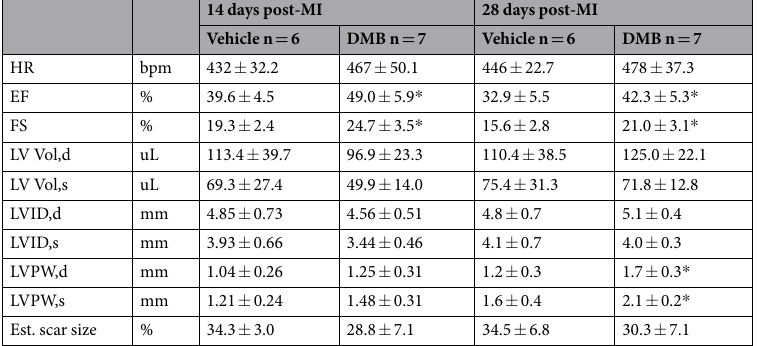
Table 1. DMB administered after permanent coronary artery ligation mitigates adverse LV remodeling and improves cardiac function. Data are presented as mean ± standard deviation. HR, Heart rate; EF, Ejection Fraction; FS, Fractional Shortening; DMB, 2-Quinoxalinamine, 6,7-dichloro-N-(1,1-dimethylethyl)-3- (methylsulfonyl)-, 6,7-dichloro-2-methylsulfonyl-3-N-tert-butylaminoquinoxaline; LV Vol,d, Left Ventricle End-Diastolic Volume; LV Vol,s, LV End- Systolic Volume; LVID,d, LV Internal Diameter, Diastole; LVID,s, LV Internal Diameter, systole; LVPW,d, LV Posterior Wall thickness, diastole; LVPW,s, LV Posterior Wall thickness, systole. Naïve EF % 60.4 ± 6.7, FS % 29.3 ± 6.3 (n = 19). * p < 0.05 vs